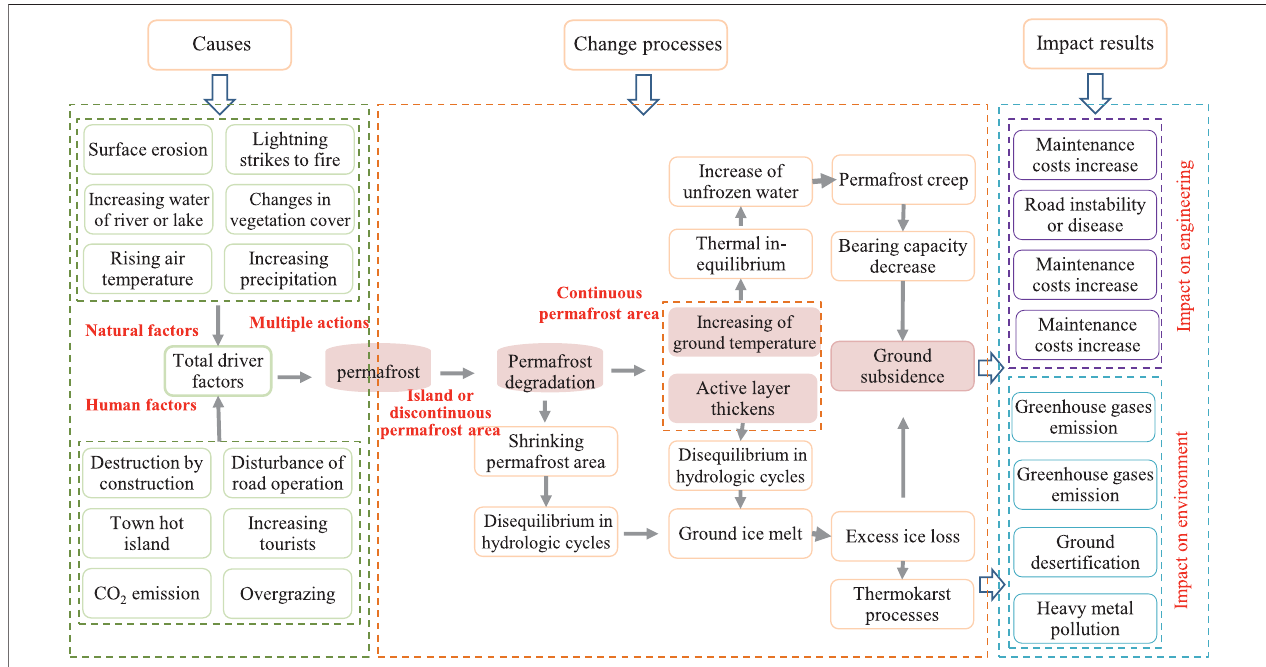
FIGURE11| Thedrivingfactorsthatcausedpermafrostwarminganddegradationanditsimpactsontheengineeringandenvironmentinahigh-altitudepermafrost area, the